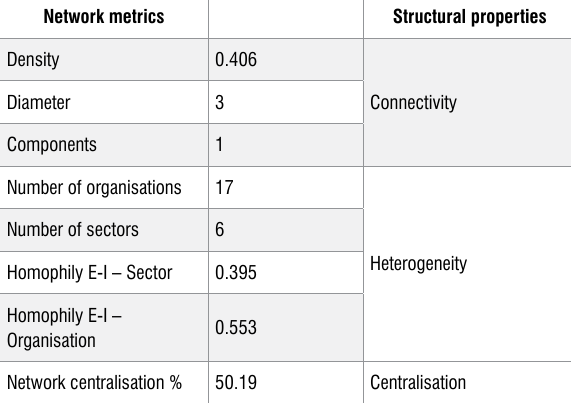
Table 3: Results of social network analysis for the Dassenberg Coastal Catchment Partnership governance network Network metrics